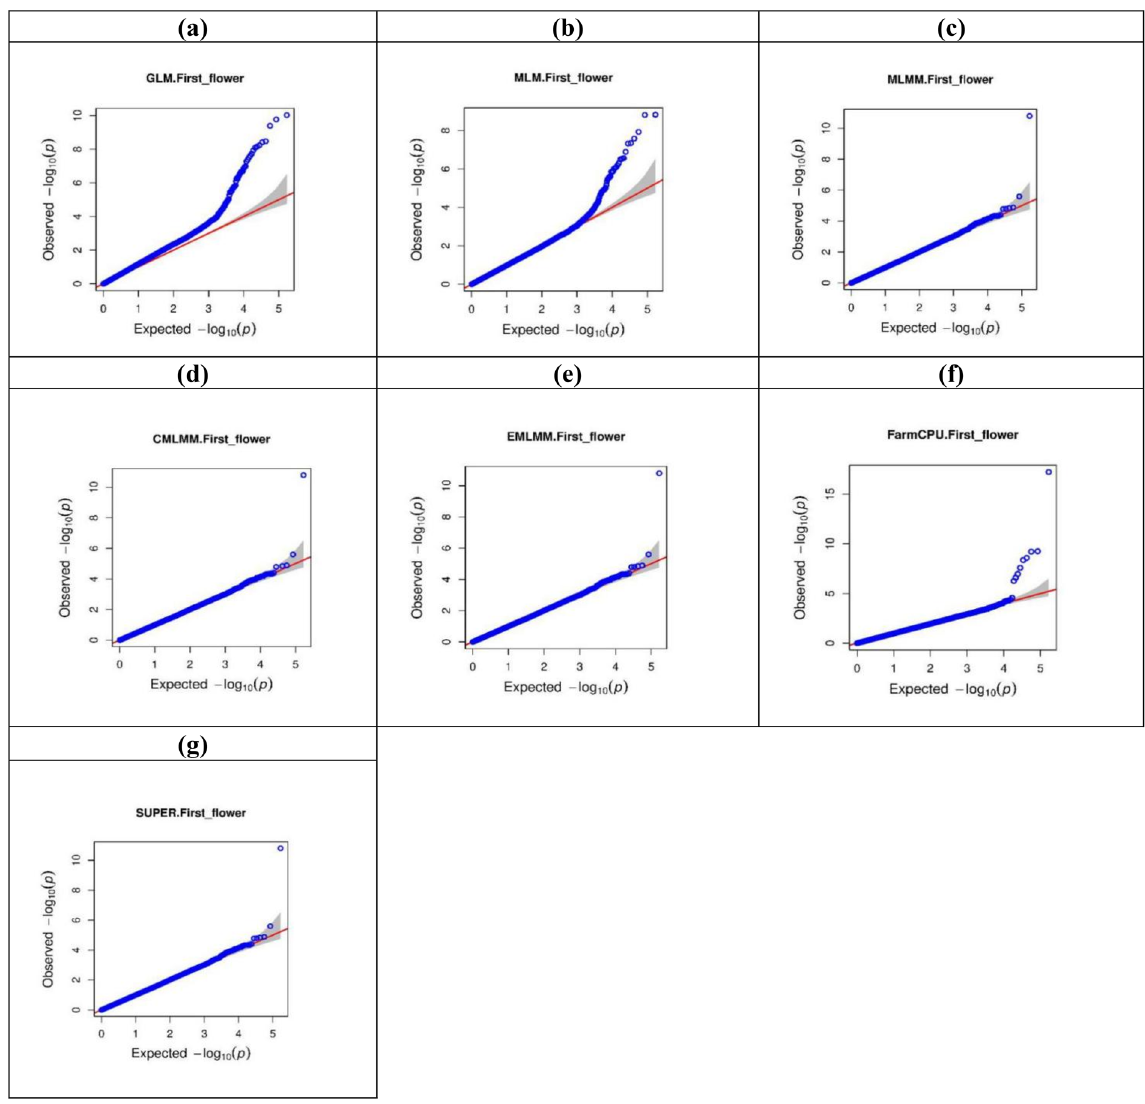
Figure 4. Quantile–Quantile (Q–Q) plots based on GWAS results from different association models for DOF in the year 2017–18. Model representations are GLM ( a ), MLM ( b ), MLMM ( c ), CMLM ( d ), ECMLM ( e ), FarmCPU ( f ) and SUPER ( g ). x axis plots expected − log 10 ( p ) values and y axis plots observed − log 10 ( p ) values